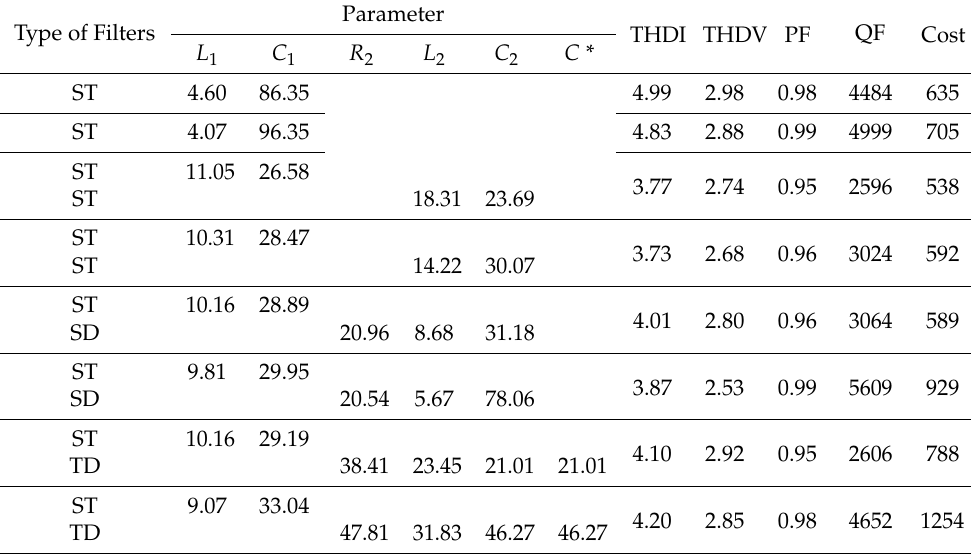
Table 10. Pareto solutions with minimum cost and maximum cost. Type of